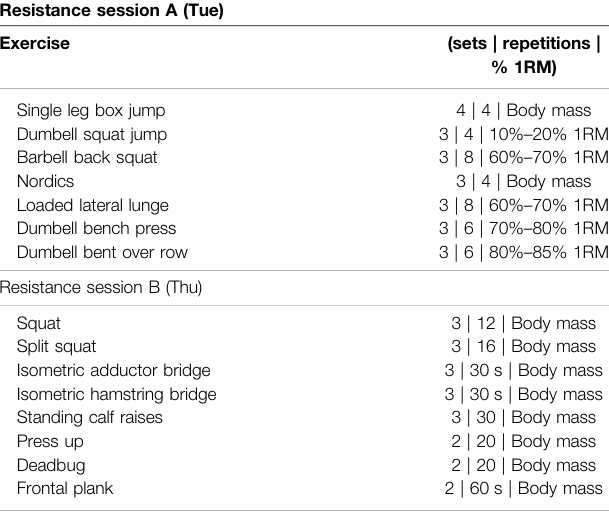
TABLE 2 | Resistance session A (Tue) and session B (Thu). Resistance session A (Tue) Exercise (sets | repetitions |